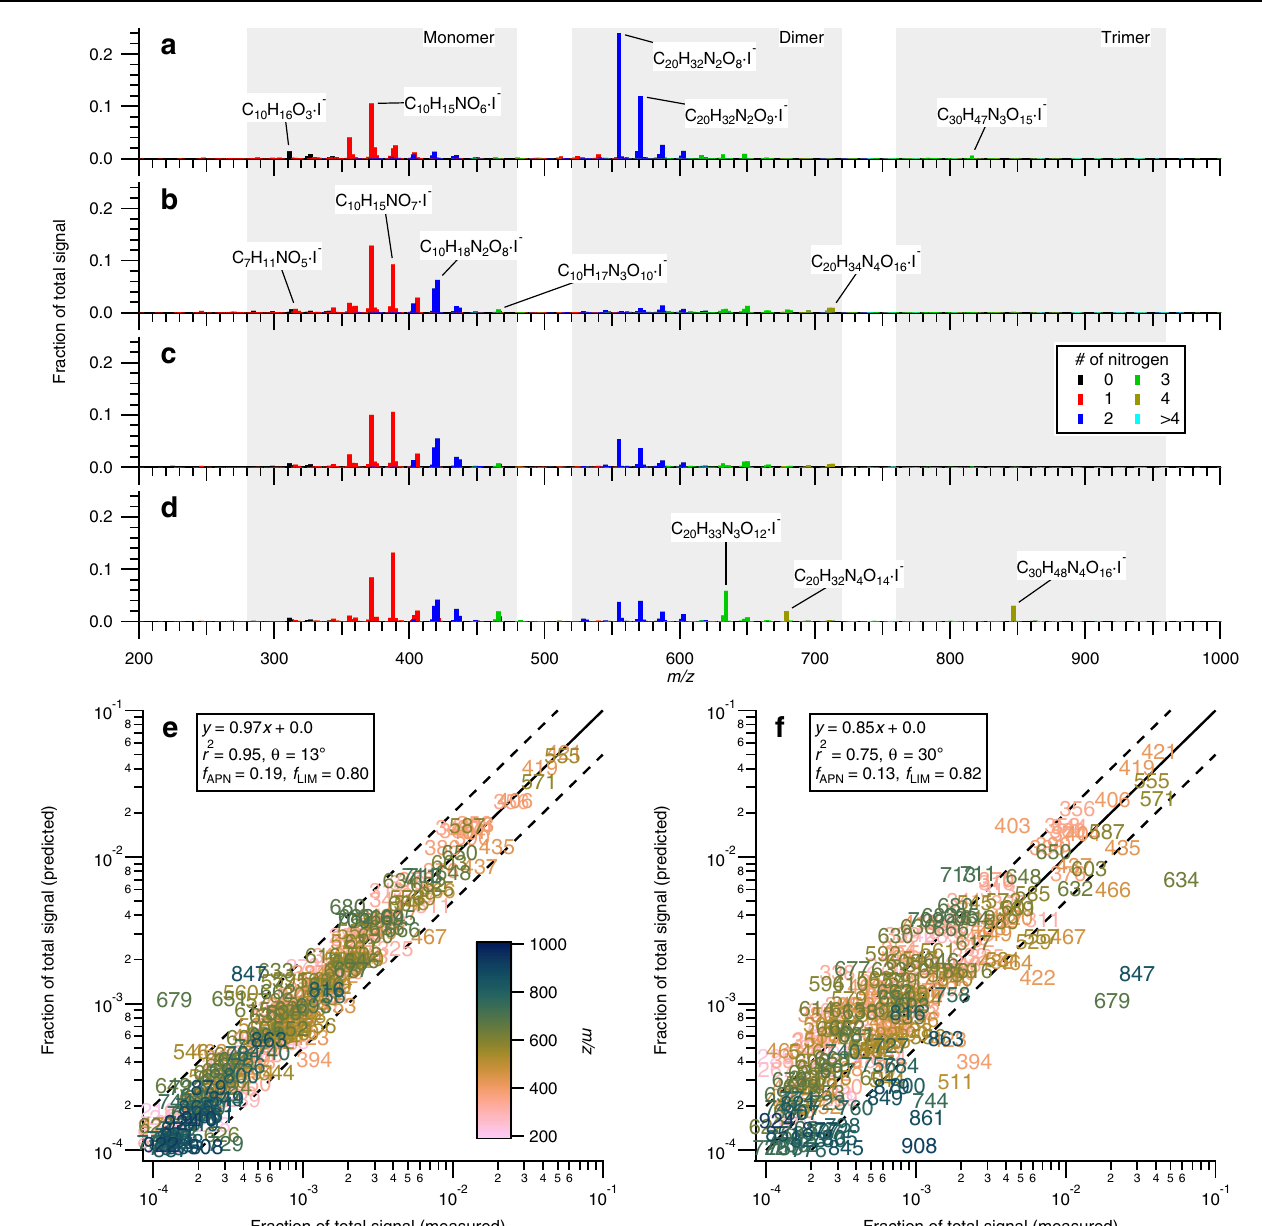
with those predicted based on linear combinations of APN and LIM experiments. Solid line indicates 1:1 and dashed lines represent a deviation by a factor of 2. Data points are labeled and colored by nominal m/z . θ is a spectral contrast angle, and f f APN and LIM indicatethesignalfractionsofAPNand LIMexperimentscontributing to secondary organic aerosol estimated via multiple linear regression analysis,